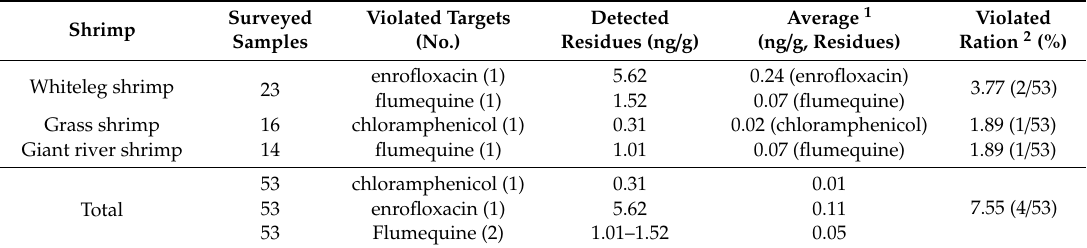
Table 1. Detection levels of banned veterinary drugs in various shrimp samples collected between July